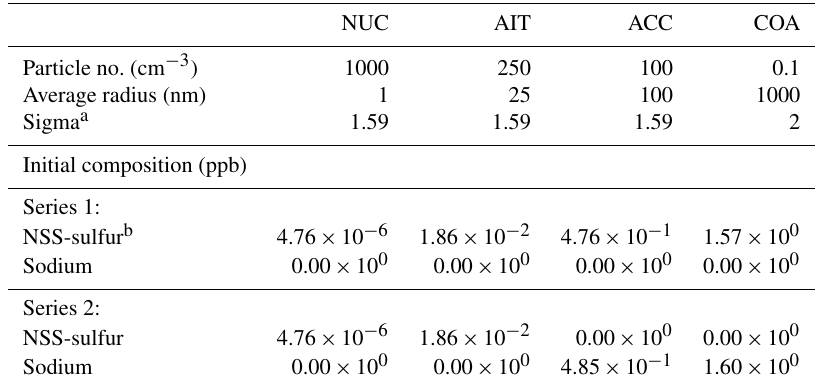
Table 2. Aerosol set-up of the size-resolved box-modelling evaluations series 1 and